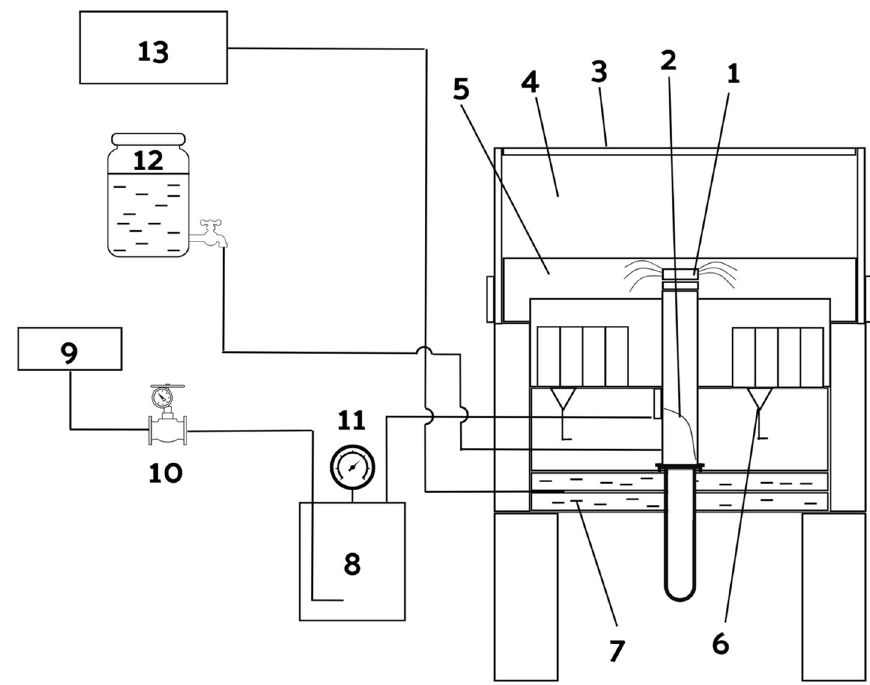
Figure 4. Salt chamber